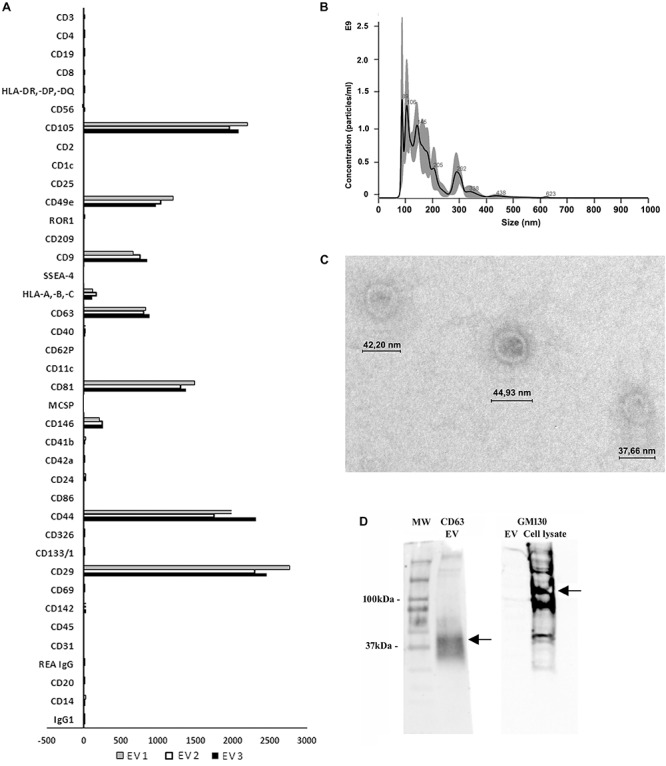
Characterisation of MSC-EVs. (A) Multiplex bead-based flow cytometry assay was used to characterise MSC-EV surface antigens. Thirty nine multiplexed populations of dye-labeled antibody-coated capture beads containing established exosomal markers were incubated with MSC-EVs and analysed by flow cytometry. Experiments were performed with three different samples. (B) Nanoparticle tracking analyses showing the size distribution and quantity of MSC-EVs purified by differential ultracentrifugation. (C) Representative transmission electron microscopy showing MSC-EVs (original magnification 150,000X). (D) Representative Western blot analysis of the exosomal marker CD63 (30–60 kDa) in MSC-EVs and negatively stained for GM130 (130 kDa) (MSC lysate was used as positive control).